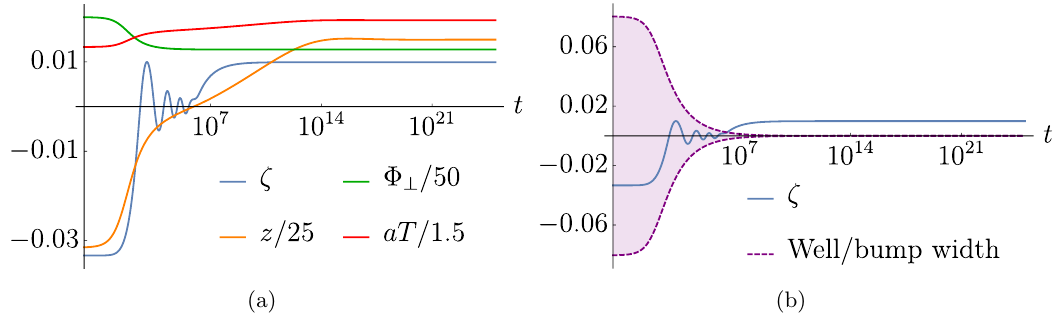
Figure 4 . (a) Numerical simulation for d = 4 of (cid:16) ( t ), z ( t ), (cid:8) ? ( t ) and a ( t ) T ( t ), in a model that realizes the dynamical phase transition responsible for a large mass generation of initially massless states. (cid:16) ( t ) oscillates with damping around 0 as long as z ( t ) < 0. When the latter become positive, (cid:16) ( t ) condenses away from the origin. (b) The shaded area represents the width of the well or bump. The oscillations are within the well, while freezing takes place away from the bump, where the potential for (cid:16) is